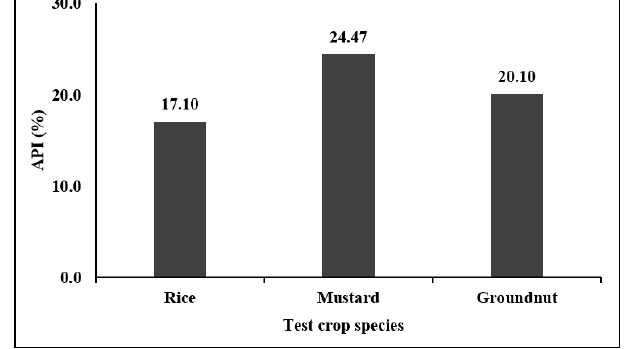
Figure 3: Mean average percent inhibition (API) of siam weed debris on